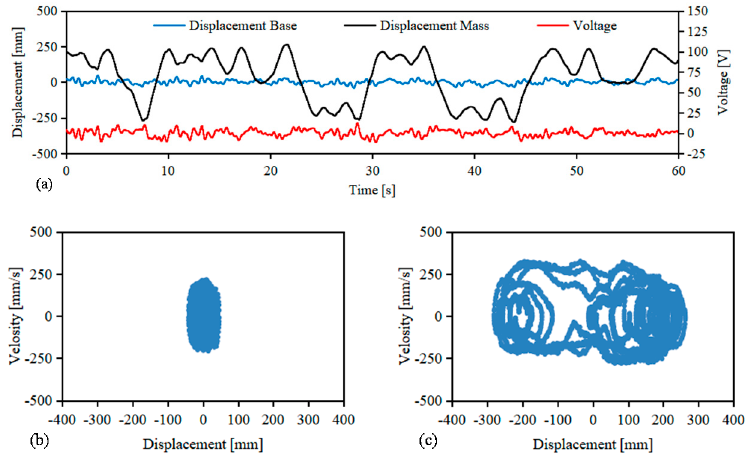
Figure 18. Measurement results of response vibration displacement and vibration power generation when vibrating with a random signal and a period signal 0.45 Hz of small amplitude 15 mm. ( a ) Results of response vibration displacement. ( b ) Diagram of displacement velocity of vibration of the support. ( c ) Diagram of displacement velocity of vibration of the mass block.